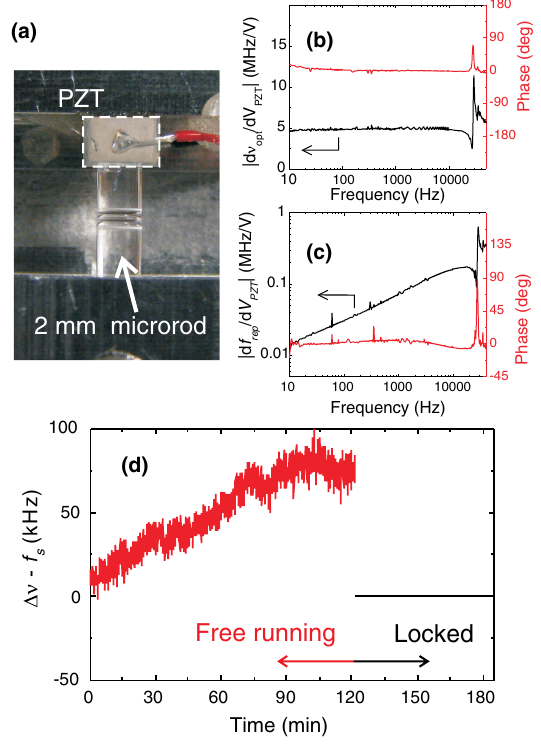
FIG. 2. Mechanical control mechanism for microresonator combs. (a) Control apparatus. A PZT compresses the microrod resonator to adjust its mode frequencies. (b, c) Response of optical resonance (b) and microcomb line spacing (c) with PZT drive frequency. (d) A three-hour record of the microcomb line spacing ( (cid:1) (cid:2) ) under free-running and stabilized conditions. The line-spacing lock point f s is 32.5671